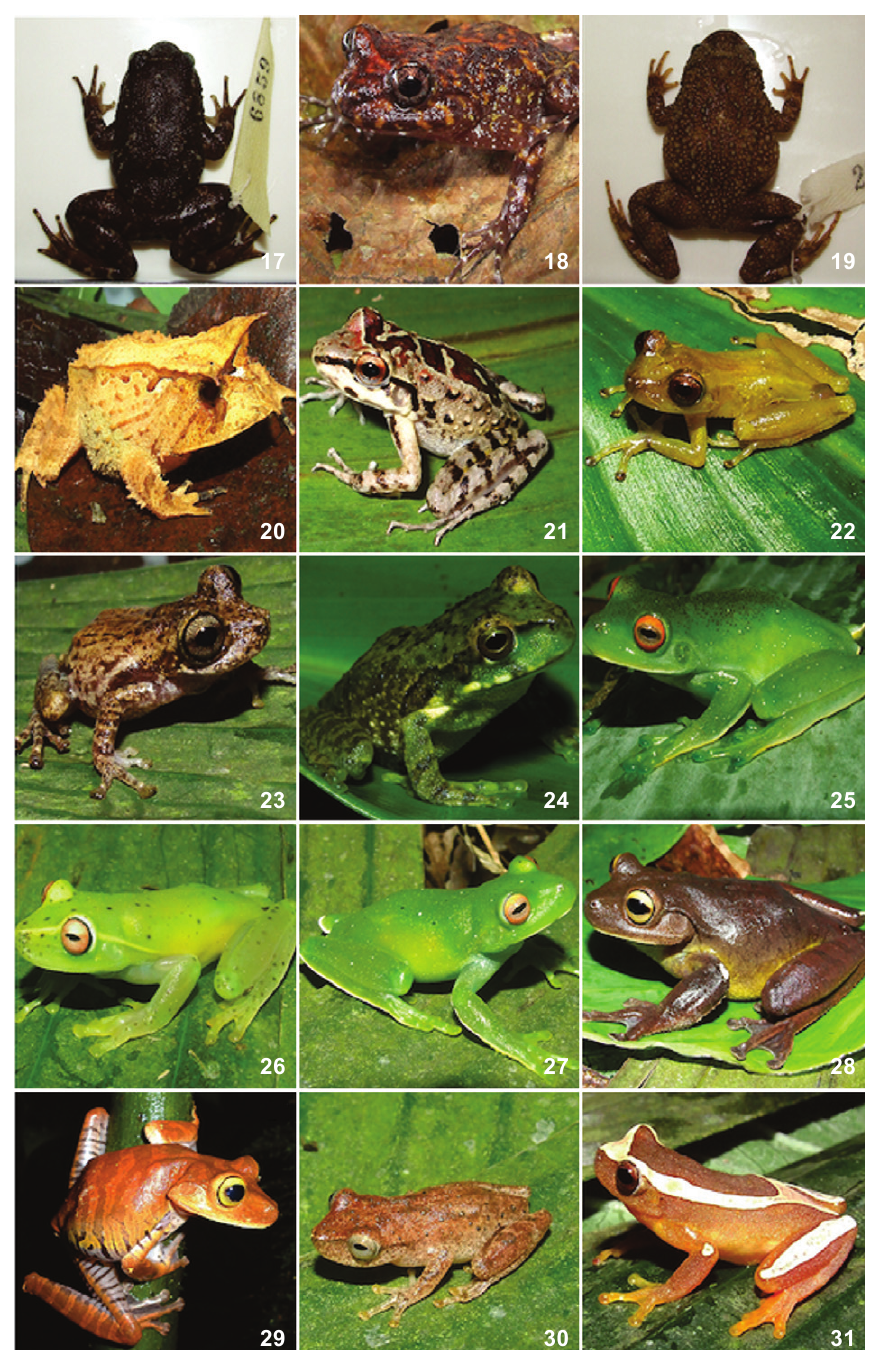
Figures 18-31. Anuran species sampled for the Parque Natural Municipal Nascentes de Paranapiacaba, Santo André, São Paulo state: (18) Cycloramphus eleutherodactylus ; (19) Cycloramphus semipalmatus (ZUEC 2722); (20) Proceratophrys melanopogon ; (21)